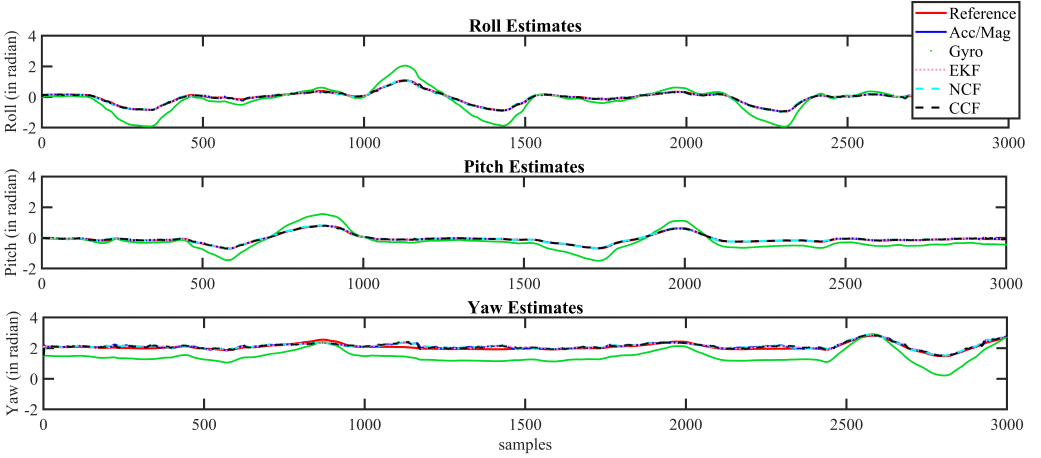
Figure 13. Attitude estimation results for Xsens dataset.